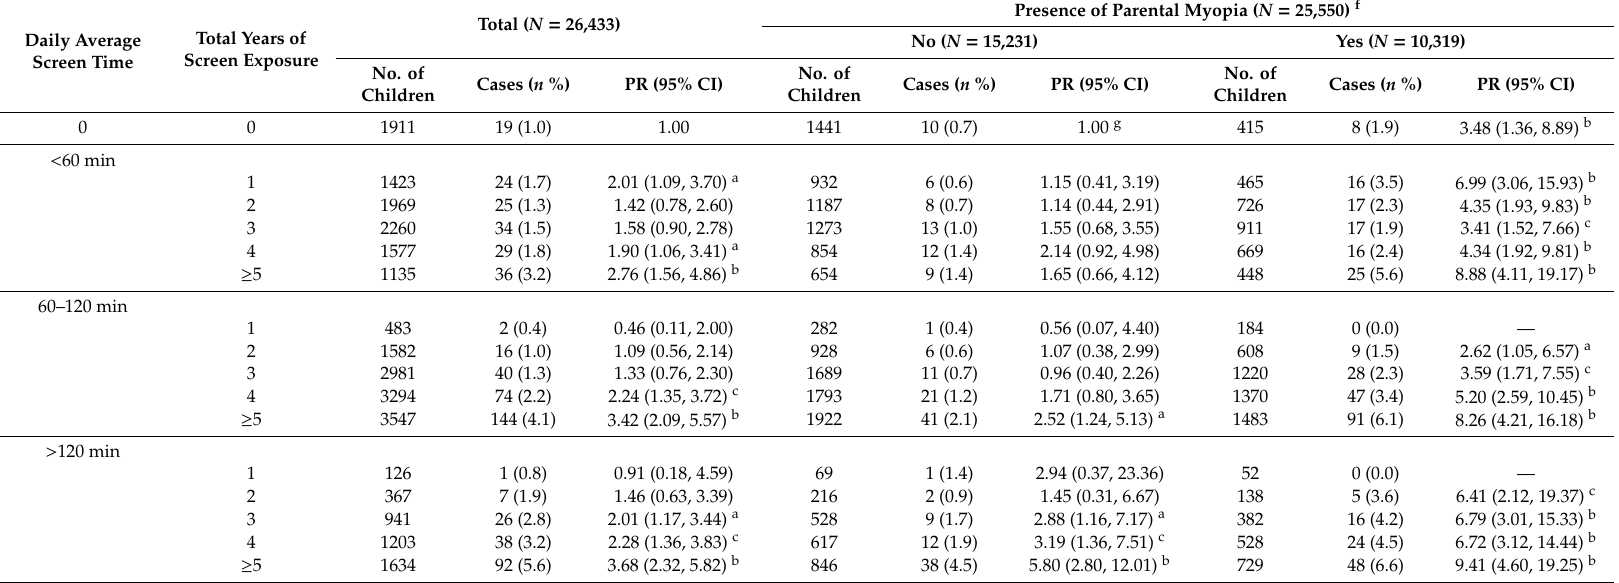
Table 3. Association between the total years of exposure, average daily screen time and preschool myopia e